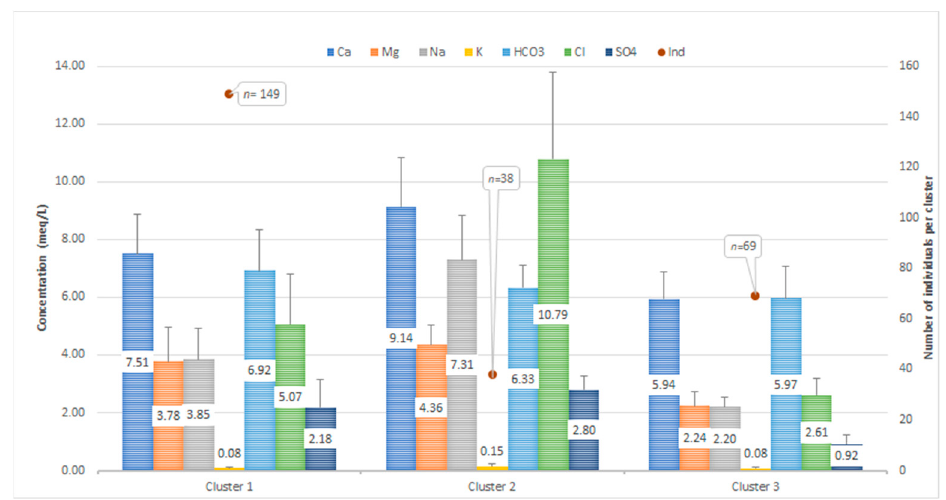
Figure 8. Mean chemical composition of each cluster obtained (columns). Mean concentration is included within each bar. Error bars represent standard deviation. The number of individuals per cluster is represented by the points.